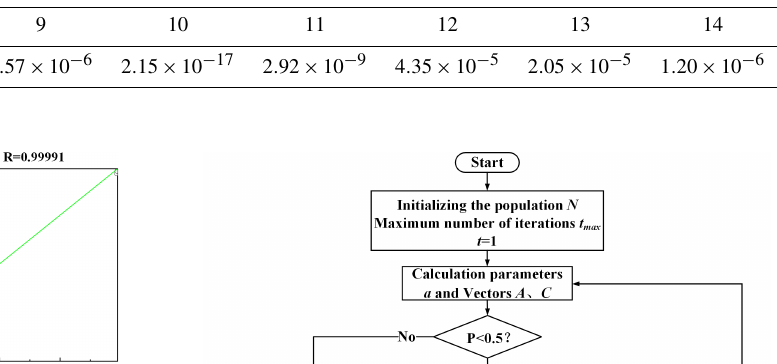
Table 5. Comparison of errors with different number of nodes.